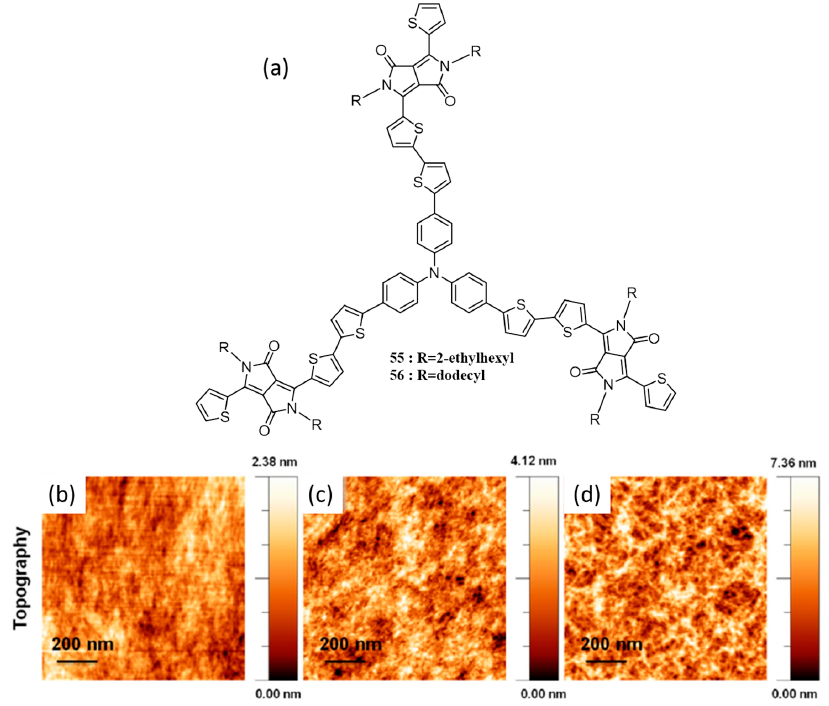
Figure 20. ( a ) The chemical structures of 55 and 56 synthesized by Stupp et al. [78]. AFM topography images of ( b ) 55 cast from chloroform; ( c ) 56 cast from chloroform; and ( d ) 56 cast from chlorobenzene. Adapted with permission from Ref. [78] Copyright 2016 American Chemical Society.